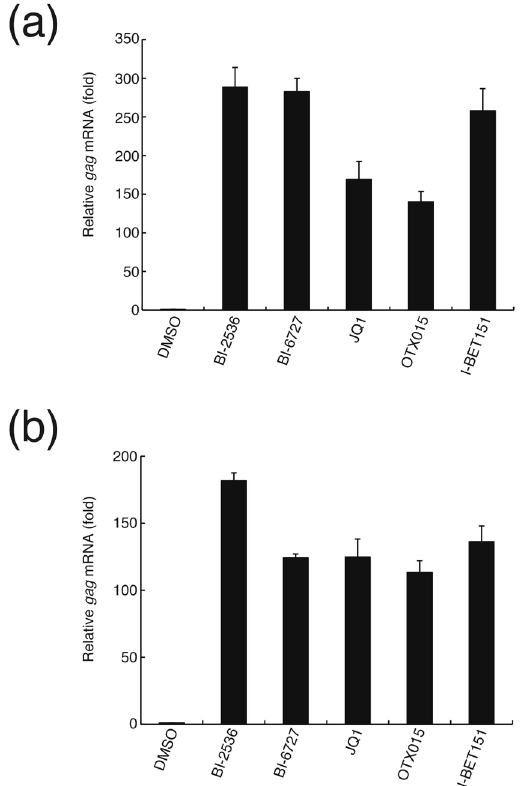
Figure 6. BI-2536, BI-6727, and various BET inhibitors reactivate latent HIV-1 provirus in ACH2 and U1 cells. ( a ) ACH2 and ( b ) U1 cells were cultured in 0.1% dimethyl sulfoxide (DMSO) only or in the presence of 1 μ M BI- 2536, 1 μ M BI-6727, 1 μ M JQ1, 3 μ M OTX015, or 10 μ M I-BET151 for 16 hours. HIV-1 gag mRNA expression was measured by quantitative RT-PCR. Fold induction of gag mRNA normalized by gapdh mRNA expression was compared with that in DMSO-treated cells. Each value is shown as a mean ± standard deviation (SD) for triplicate